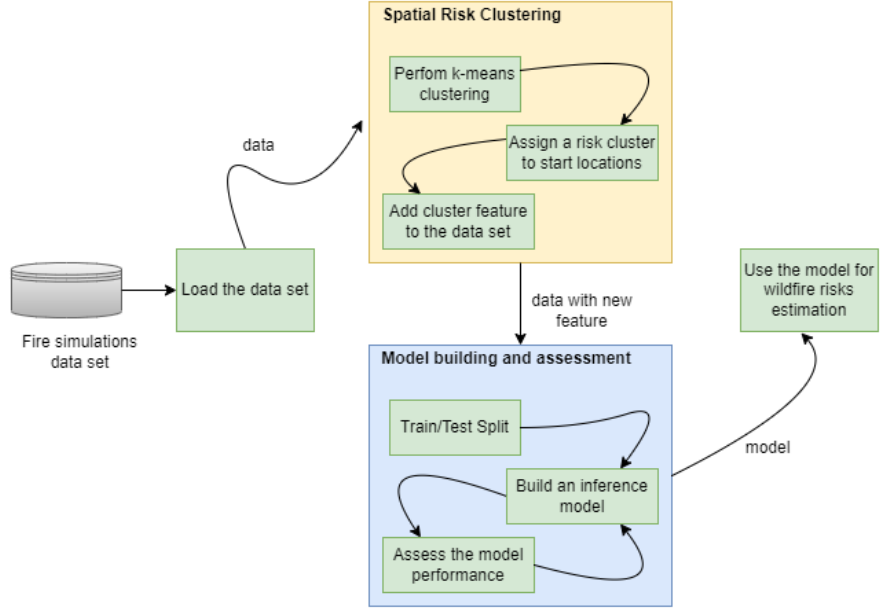
Figure 3. Workflow for the risk metric leveraged with spatial risk clustering.